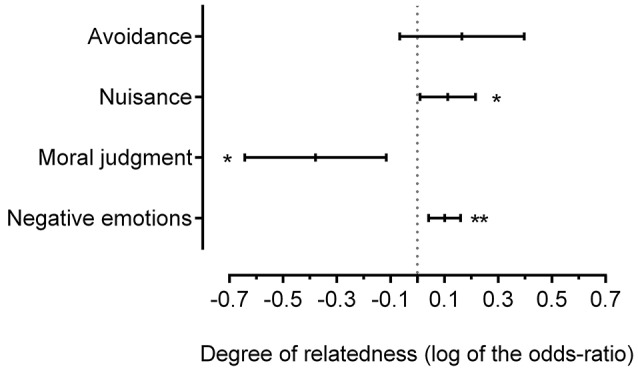
Influence of the degree of relatedness on aversive reactions (log of the odds-ratio, LOR and 95% confidence interval CI; the “avoidance” measure is a reversed one). The degree of relatedness implies 3 ordinal modalities: brother/sister (r = 0.5), uncle-aunt/niece-nephew (r = 0.25) and cousins (r = 0.125) intercourse. If LOR = 0: the degree of relatedness does not affect the odds of outcome; LOR > 0: the degree of relatedness is associated with higher odds of outcome; LOR < 0: the degree of relatedness is associated with lower odds of outcome. *p < 0.05; **p < 0.005.